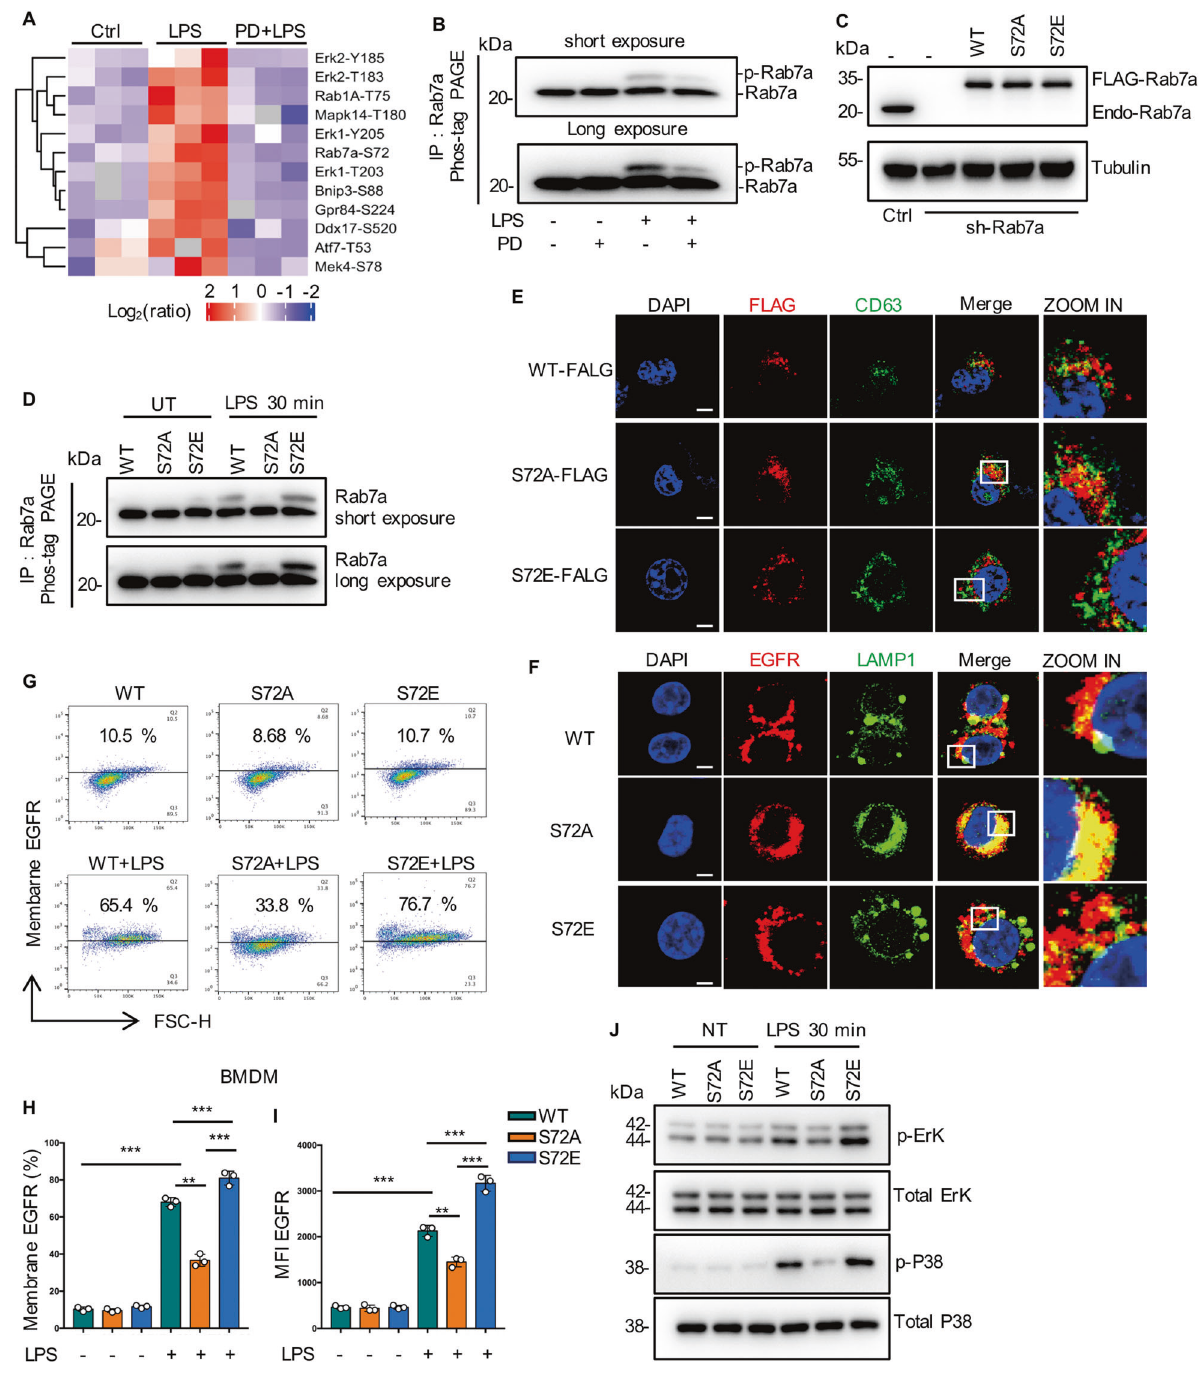
Fig. 2 Phosphorylation of Rab7a on S72 promotes late EGFR endocytosis. A Cluster analysis of differentially expressed proteins and phosphopeptides in RAW264.7 measured after treated with LPS (1 µg/mL) for 30 min with or without PD168393 (PD 10 µM) pretreatment for 30 min, when compared with control. Blue and red indicates down-or upregulation, respectively ( n = 3 samples of each condition). B PD168393 (PD 10 µM) inhibited Rab7a phosphorylation in response to LPS (30 min). The indicated cells were subjected to depolarization, and cell extracts were subjected to phostag-PAGE with Rab7a antibody by immunoblotting. C Stable expression of Rab7a-WT, Rab7a-S72A or Rab7a-S72E mutant in Rab7a shRNA knockdown RAW264.7 cells. Rab7a total protein expression was measure by western blot. a-Tubulin as a loading control. D a-Rab7a immunoprecipitates from the indicated cells were separated by phostag-PAGE followed by immunoblotting with a-Rab7a antibodies. E Immune-staining of Flag-Rab7a and CD63 in the indicated Rab7a mutant RAW264.7 cells followed by LPS treatment (1 µg/mL) for 30 min. Scale bar, 5 μ m. F Immune-staining of EGFR and LAMP1 in the indicated Rab7a mutant RAW264.7 cells followed by LPS treatment (1 µg/mL) for 24 h. Scale bar, 5 μ m. G – I The indicated Rab7a mutant RAW264.7 cells followed by LPS treatment (1 µg/mL) for 24 h. G EGFR expression on the surface of RAW264.7 was analyzed by fl ow cytometry. H Percentage of EGFR-positive RAW264.7 is shown ( n = 3). I Mean fl uorescence intensity (MFI) is shown ( n = 3). J Cell lysates from the indicated Rab7a mutant RAW264.7 cells followed by LPS treatment (1 µg/mL) for 24 h were prepared, and phospho-ERK, total ERK, total p38 and phospho-p38 protein expression was measure by western blot. The graphs depict mean ± SD based on three independent experiments. * P < 0.05, ** P < 0.01, *** P <